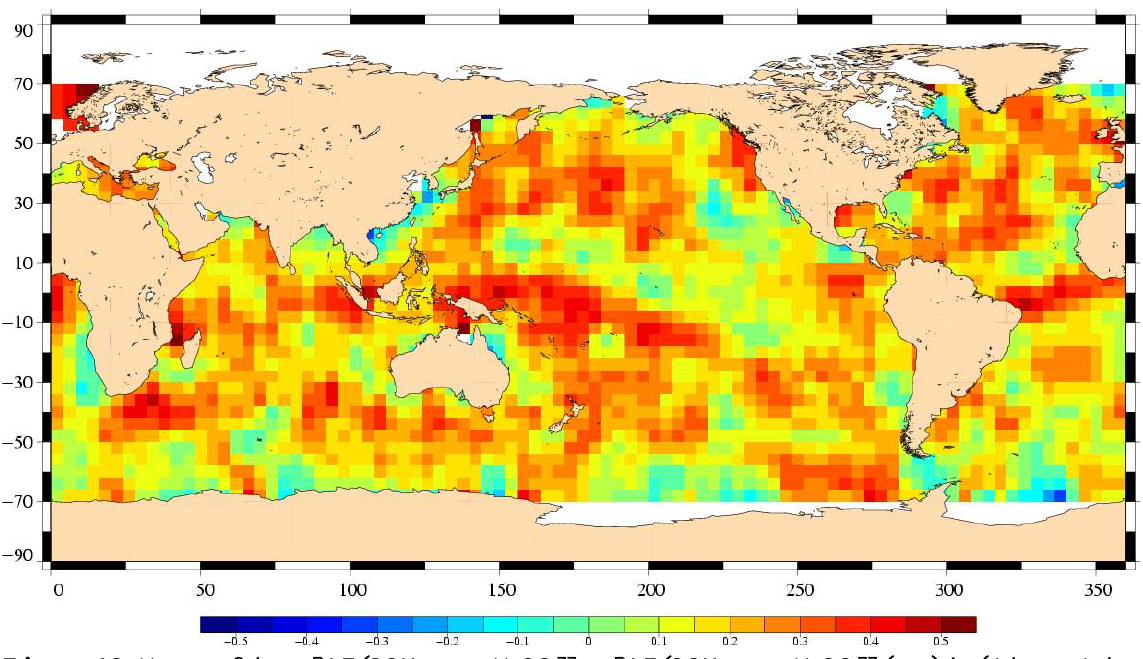
Figure 13. Maps of the σ [HF(SSH -MSS]]- σ [HF(SSH -MSS]] (cm) in (4deg x 4 deg) Jason-1 Envisat geographical bins through a 35-day period (cycle Envisat 23) where σ [HF(SSH-MSS)] is the standard deviation of the high frequency part of the SSH–MSS